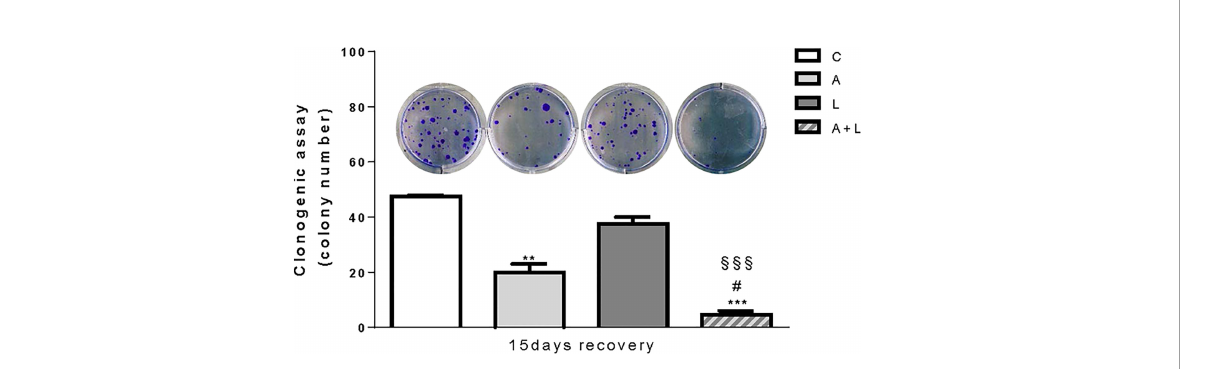
FIGURE 6 The anti-proliferative effects of abemaciclib and lenvatinib combination persisted after drug withdrawal. HUH7 after 6 days of drug treatments, the cells were harvested, seeded at low density, and cultured for additional 15 days in the absence of the drugs (recovery). Representative images of crystal violet staining of colonies are shown. **p<0.01,***p<0.001 vs C; # p<0.05 vs A; §§§ p<0.001 vs L. Data are mean values ± SD of two independent